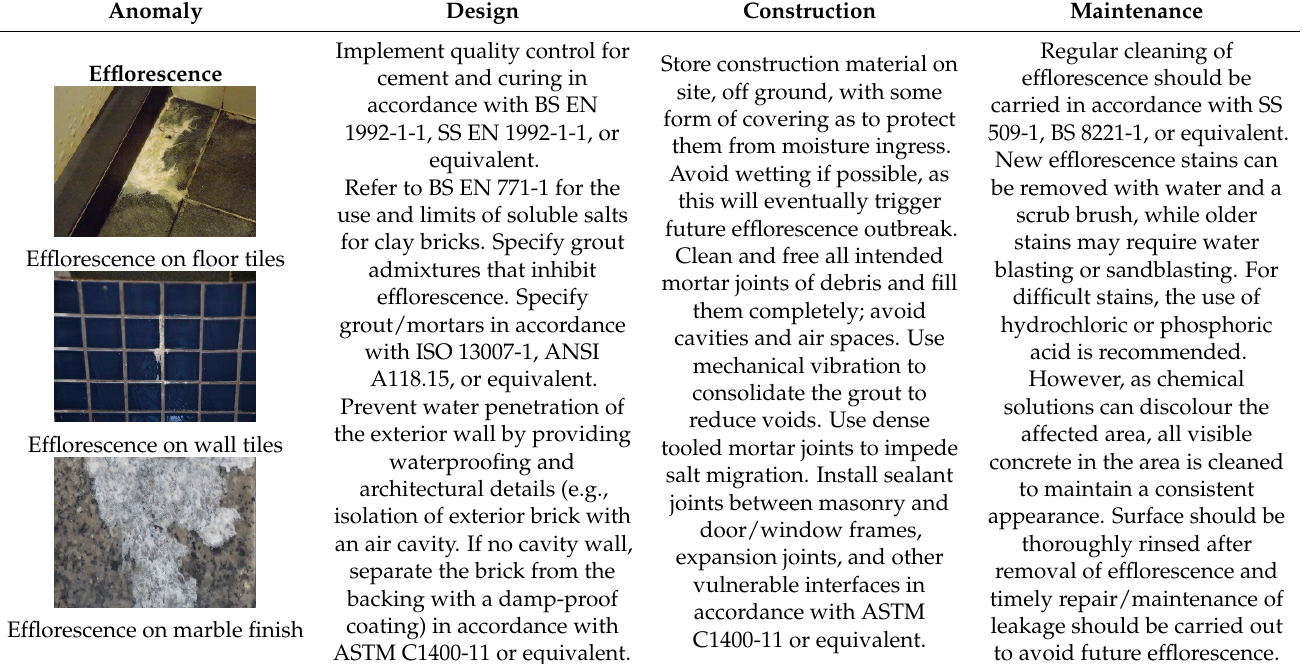
Table 6. Wet Areas—Architectural components e.g., finishes, furnishings, and other elements that contribute to the aesthetic value and liveability.